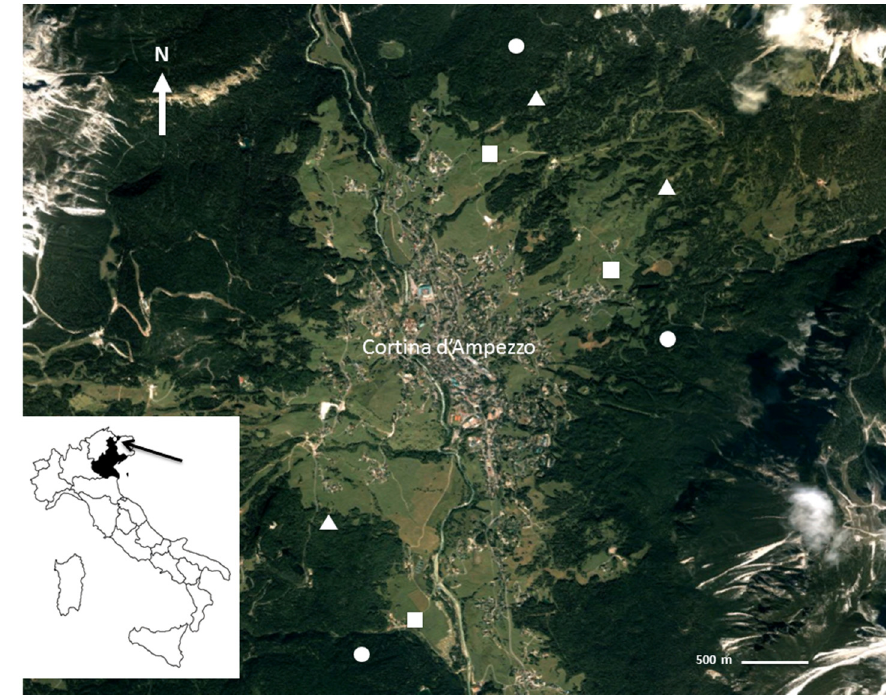
Figure 1. Map of Cortina d’Ampezzo Valley (Northestern Italy) indicating the study locations (circle, forest; triangle, reforestation; square, prairie).